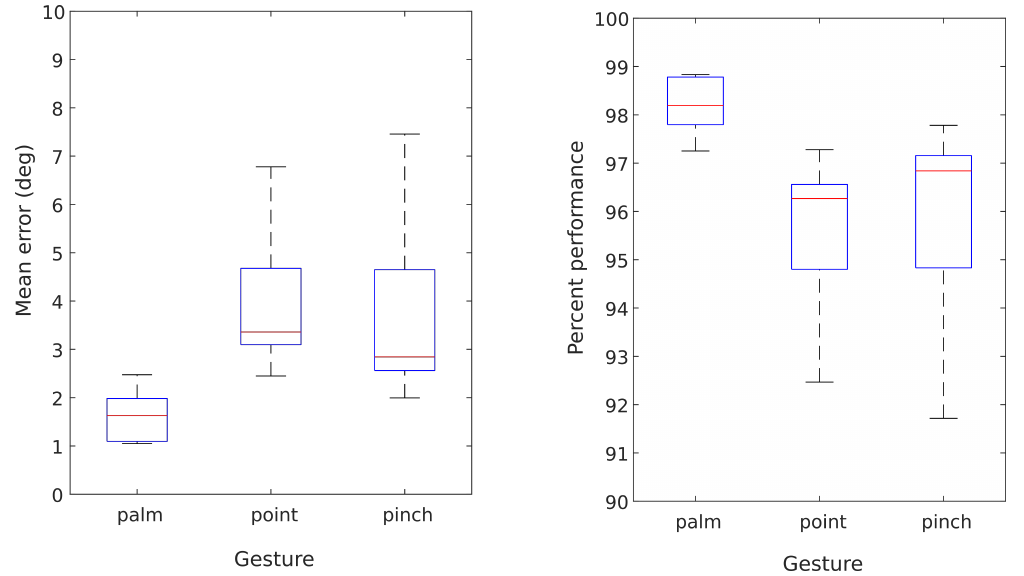
Figure 11. Graph comparing gesture performance on final run across